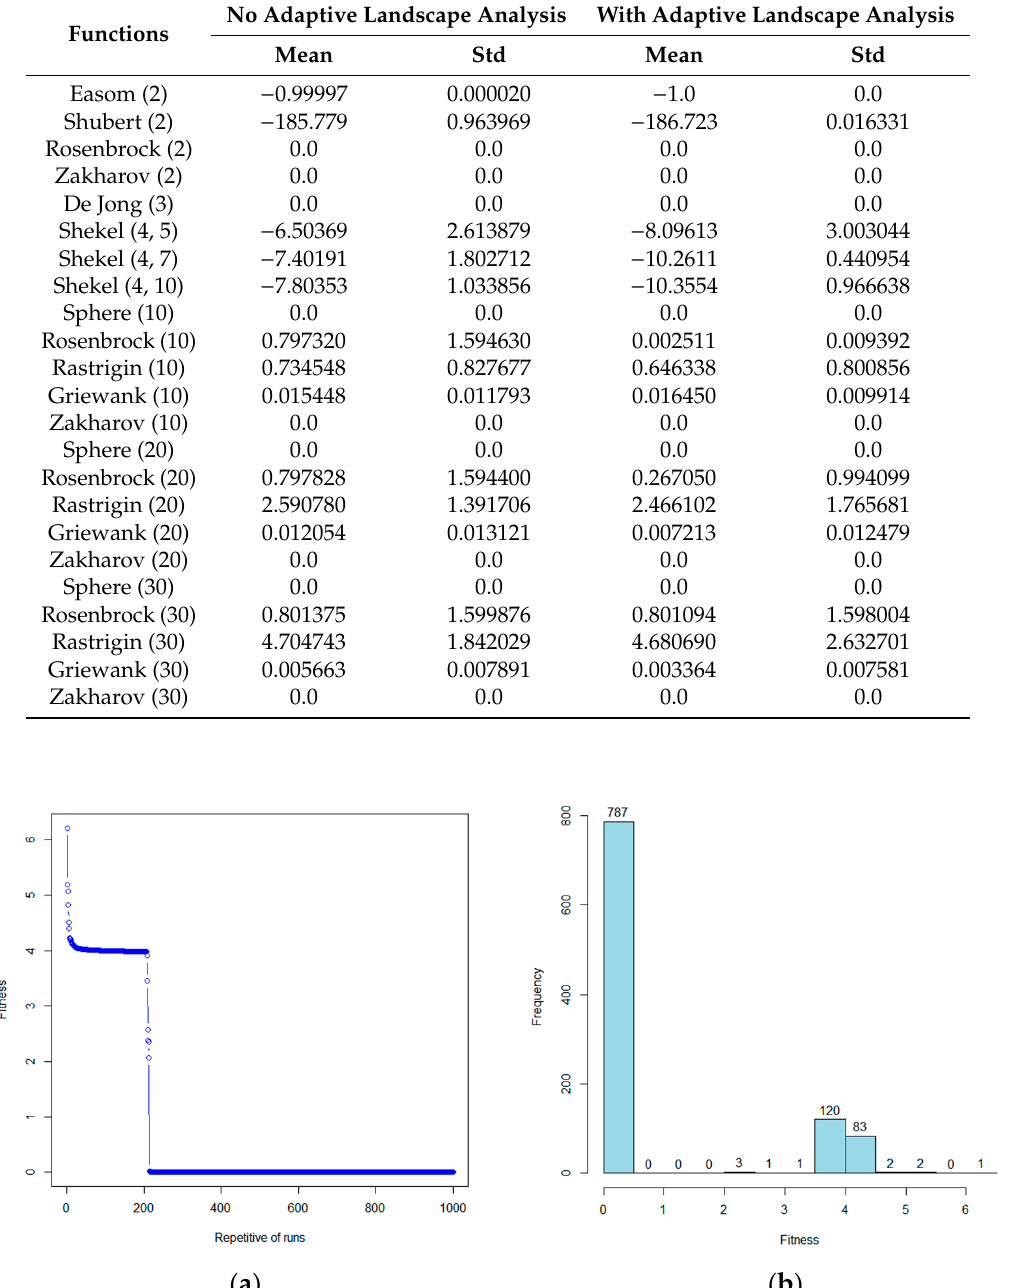
Table 6. The mean best function value and the standard deviation obtained by CFA with or without landscape analysis.